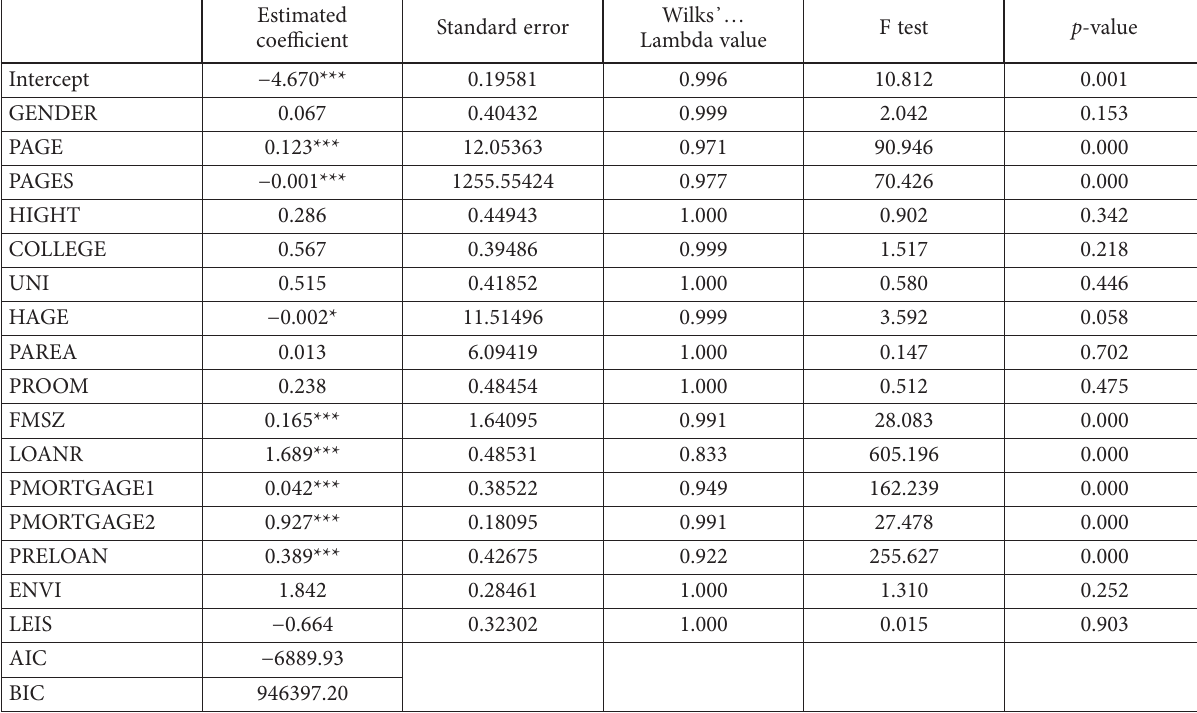
Table A3. Function coefficients estimated with discriminant analysis Estimated